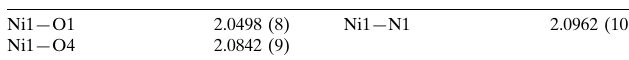
Selected bond lengths (A˚ ).